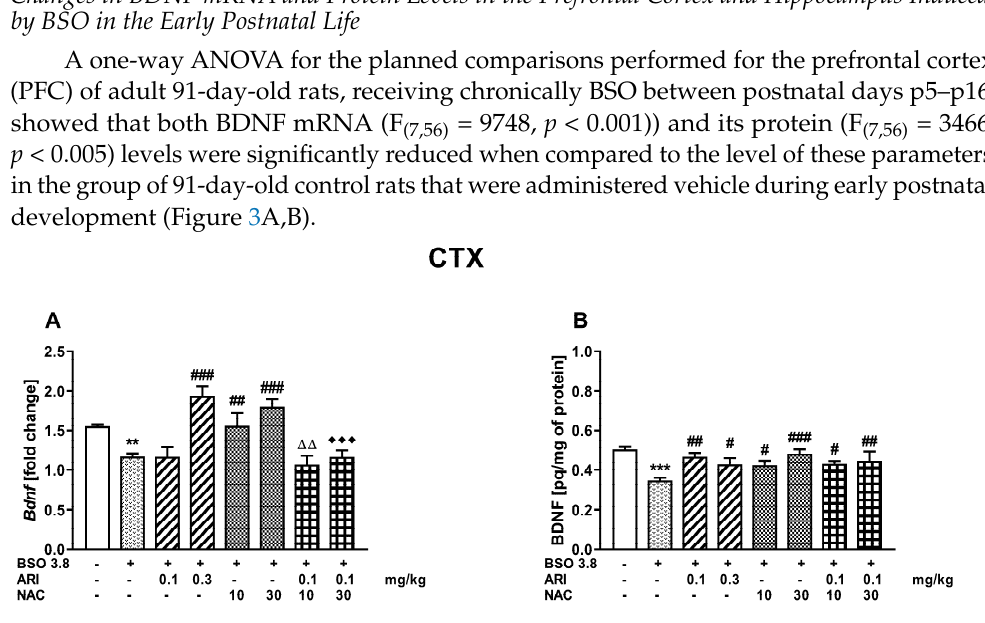
Figure 3. Effects of chronic administration of aripiprazole (ARI) and N-acetylcysteine (NAC), alone or in combination, on BDNF mRNA ( A ) and protein ( B ) levels in the prefrontal cortex of adult 91-day-old Sprague–Dawley rats that received chronic BSO during early postnatal life (P5–P16). Data are presented as the mean ± SEM, n = 8 for each group. Statistical analysis was performed using a one-way ANOVA for the planned comparisons; symbols indicate significance of differences between the tested groups, *** p < 0.001, ** p < 0.01 vs. control vehicle-treated group; ### p < 0.001, ## p < 0.01, # p < 0.05 vs. BSO-treated group; ∆∆ p < 0.01 vs. BSO + NAC (10 mg/kg)-treated group; ♦♦♦ p < 0.001 vs. BSO + NAC (30 mg/kg)-treated group.